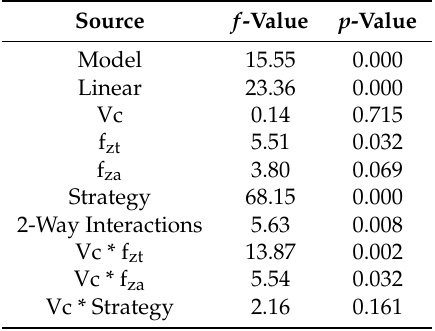
Table 10. Variance analysis for Ra.